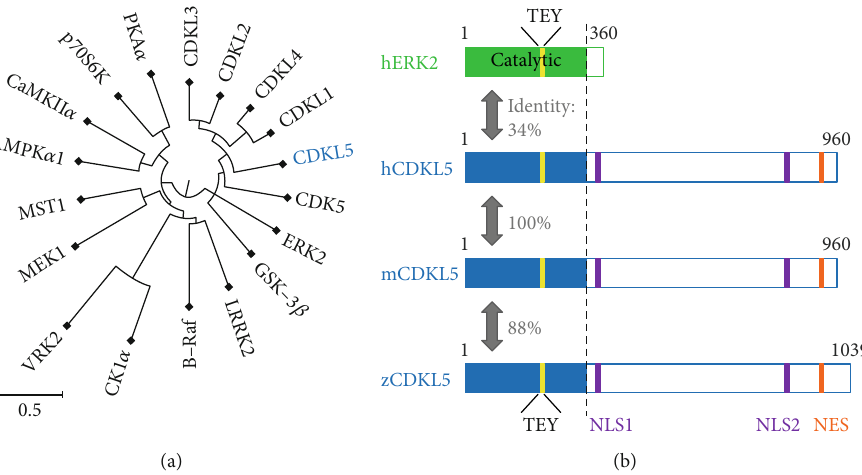
Figure 1: Primary structure and molecular phylogenetic tree of CDKL5. (a) Circular phylogenetic trees for the catalytic domains of CDKL5 and various kinases were generated using the CLC sequence viewer version 8.0. Scale bars indicate substitution rates of amino acids (50% amino acid substitution rate per bar length). (b) Schematic illustration of the primary structure of CDKL5 from human (accession no. NP_001310218.1), mouse (mCDKL5_1 in Hector et al. [29]), and zebra fi sh (accession no. NP_001124243.1) and of ERK2 from human (accession no. NP_620407.1). The catalytic domains of enzymes have been coloured blue and green, respectively. The TEY sequence corresponding to the activation loop is shown in yellow, the nuclear translocation sequence in purple, and the nuclear export sequence in orange. Amino acid identity between each catalytic region is